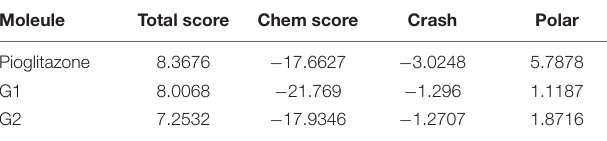
TABLE 1 | In sillco docking results of novel glitazones (G1 & G2) and reference ligand